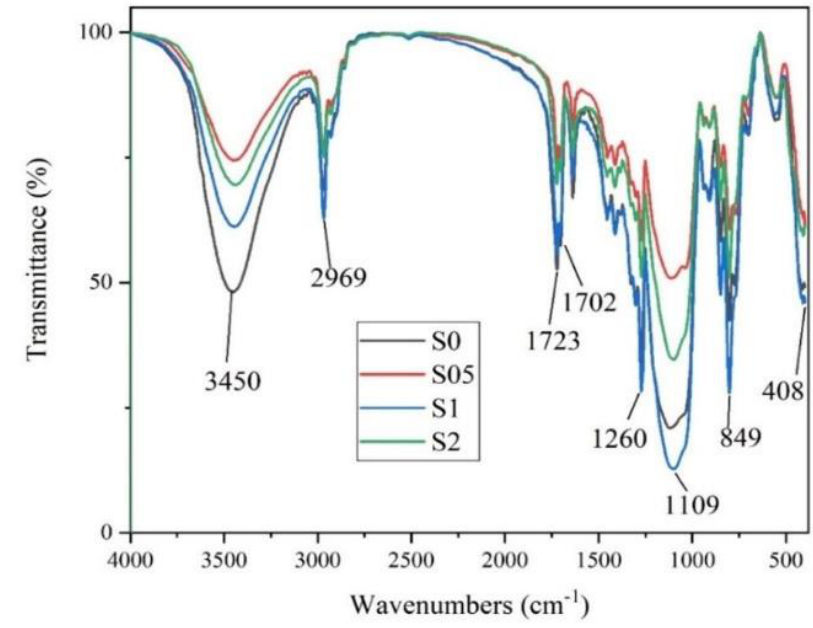
Figure 2. infrared spectra of nano SiO 2 particles modified coatings with different weight ratio. Figure 2. Infrared spectra of nano SiO 2 particles modified coatings with different weight